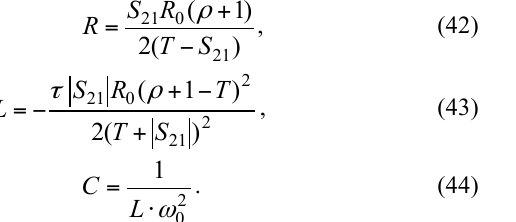
m = 220 nH, C = 10 nF). b b = 9 V b